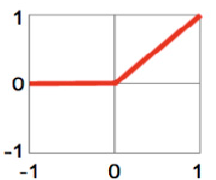
Figure 23. Pictorial representation of Rectified Linear Unit (ReLU).